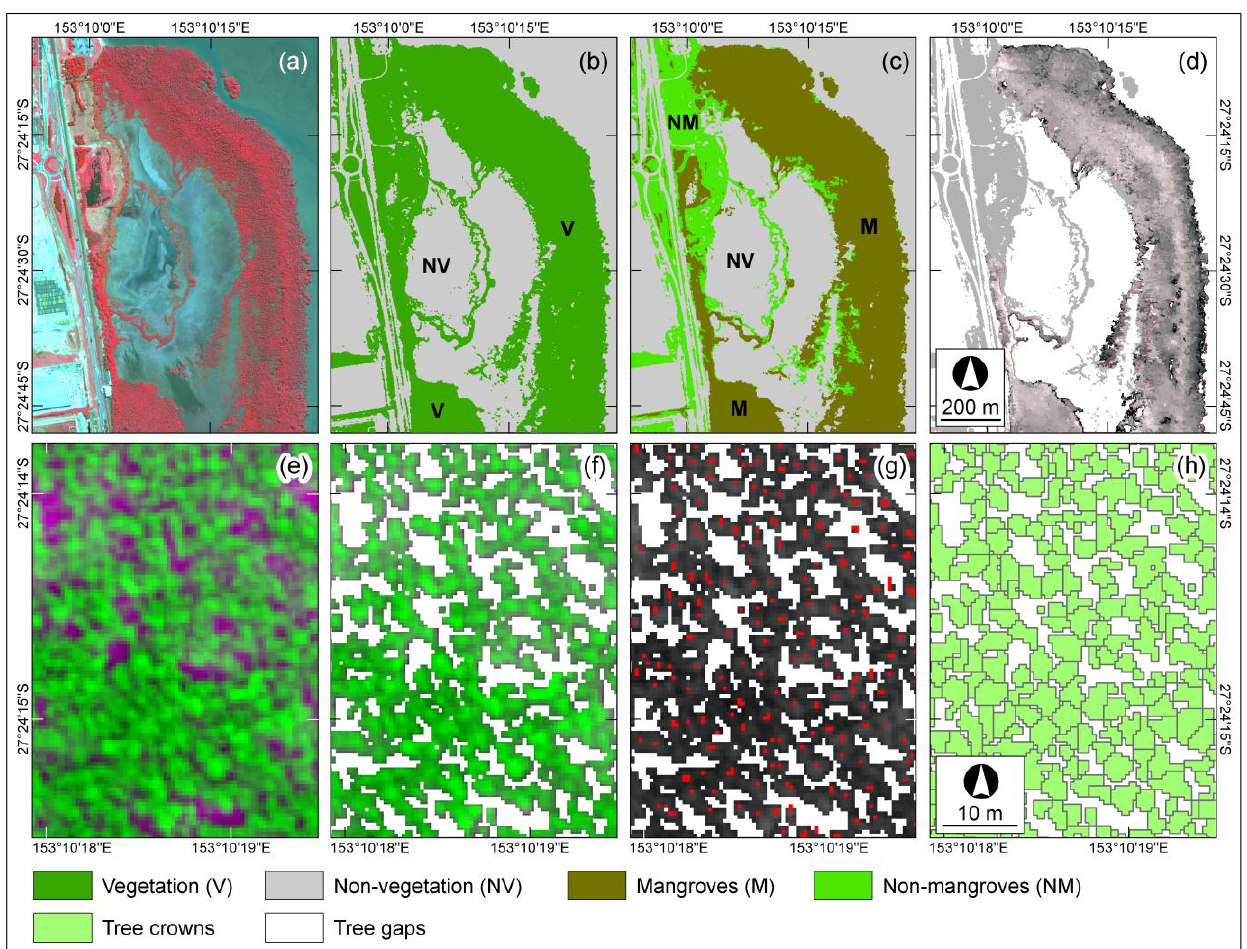
Figure 6. Subset of Whyte Island maps, showing ( a ) WV-2 standard false color composite, ( b ) vegetation (V) and non-vegetation (NV) discrimination using FDI, ( c ) spectral-based mangroves (M) and non-mangroves (NM) separation, and ( d ) band combination image to enhance the mangrove zonations. Tree crown delineation process showing ( e ) color composite of PC1, PC2, PC1 (RGB), ( f ) masked canopy gaps (white), ( g ) tree canopy seeds (red) on top of NIR band, and ( h ) tree crown polygons derived from region growing. At the Moreton Bay site, a ratio of the spectral reflectance distance between NIR to red, and green to red ([NIR-red]/[green-red]) was found to be effective in separating mangrove from non-mangrove objects in the WV-2 imagery (Figure 6c). The NIR and red bands were also found useful for discriminating mangrove objects in the AVNIR-2 imagery, as were the NIR and the first mid infrared (MIR1) band for the TM image (Table 3). To enable comparison with the spectral-based only approach, the contextual information in the form of a DTM derived from LiDAR data was also used in this process in combination with the WV-2 image. The DTM was used to set an elevation boundary above sea level for mangrove habitats that commonly occur in the lower parts of tidal flats in coastal or riverine areas, which is frequently inundated by saline water. Limiting the delineation to the typical elevation of mangrove habitats will increase the accuracy of the classification and compensate for limitations of spectral-based